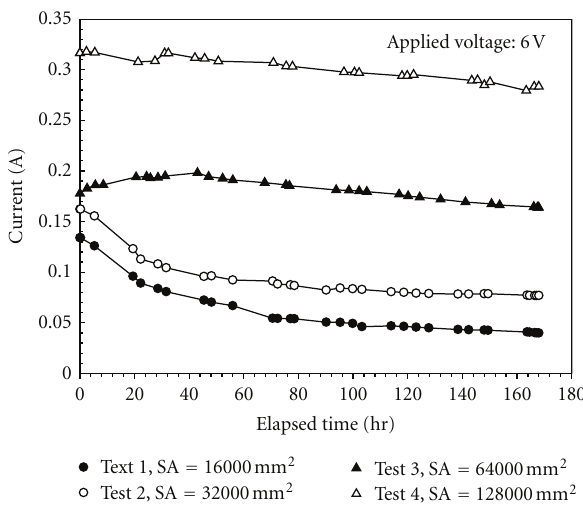
Figure 2: Electric current versus elapsed time of the